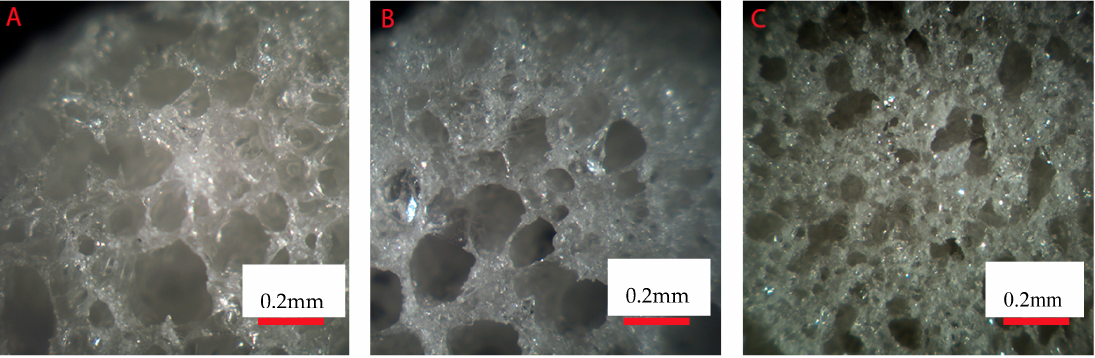
Figure 1. Optical microscope image of the scaffolds’ cross section: ( A ) 10; ( B ) 30 and ( C ) 50 wt % of borosilicate glasses.